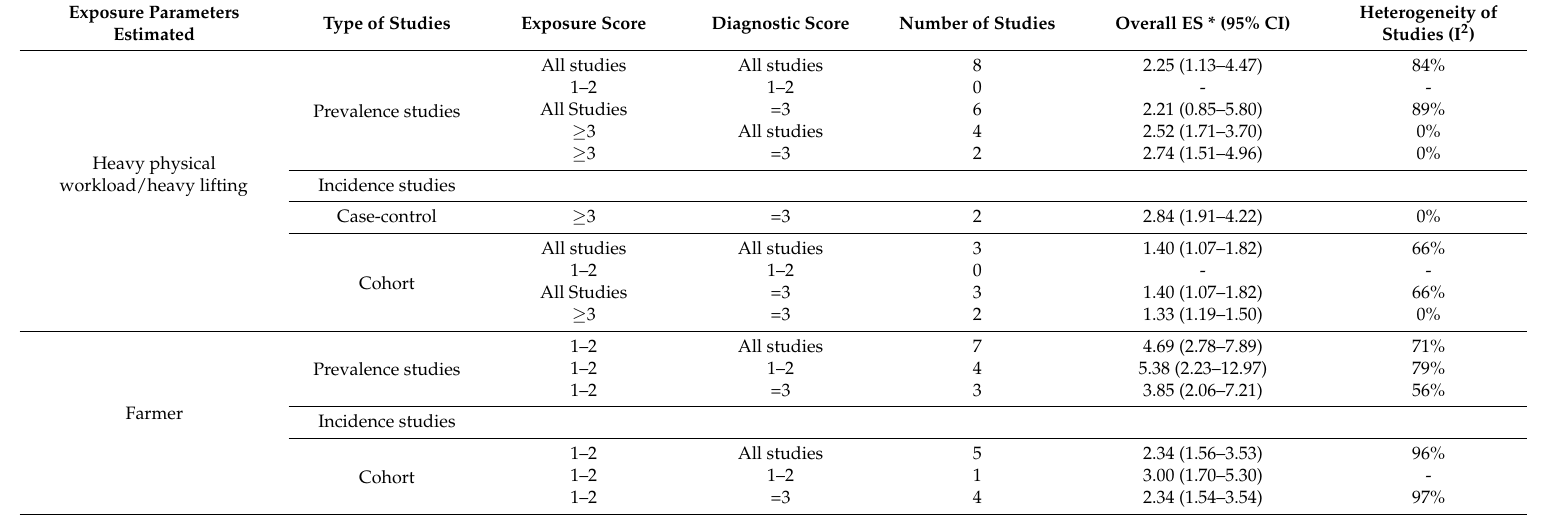
Table 5. Results of meta-analysis depending on the type and quality level of published studies for